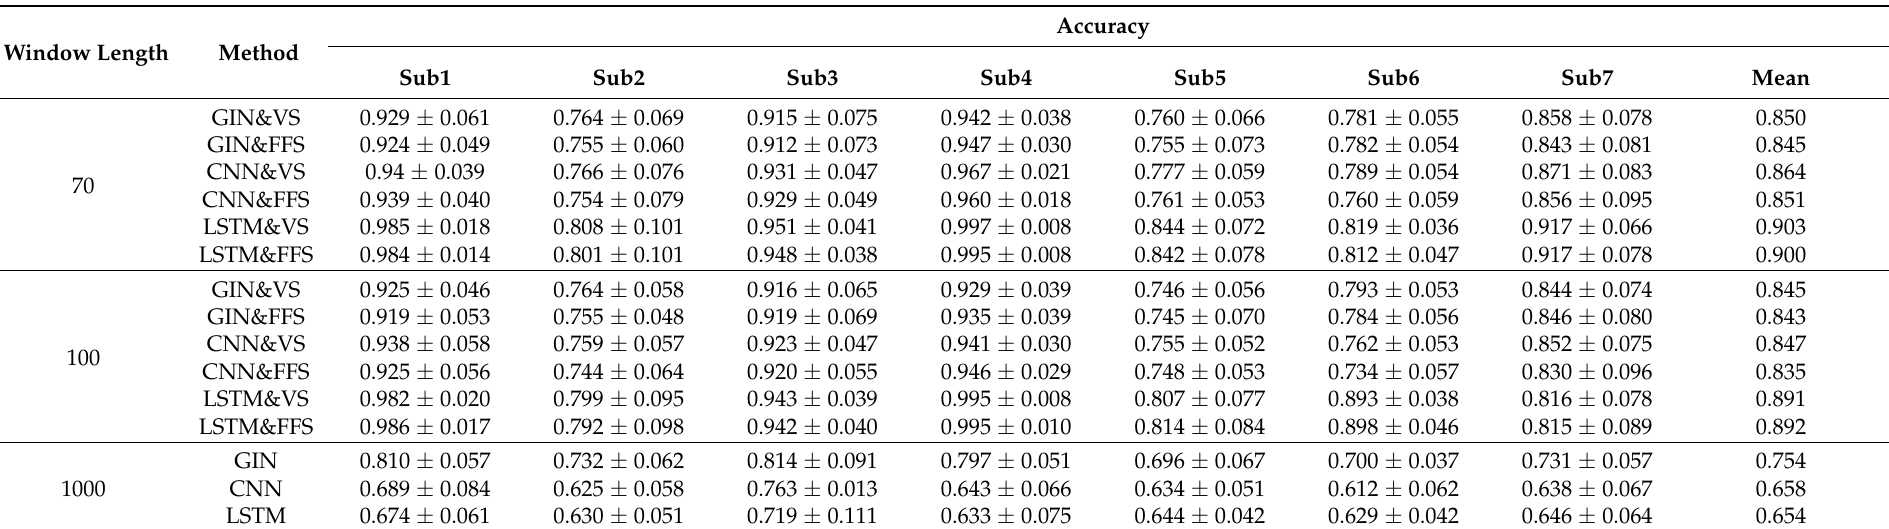
Table 4. Comparison of the accuracies of different methods with time windows of 60, 70, and